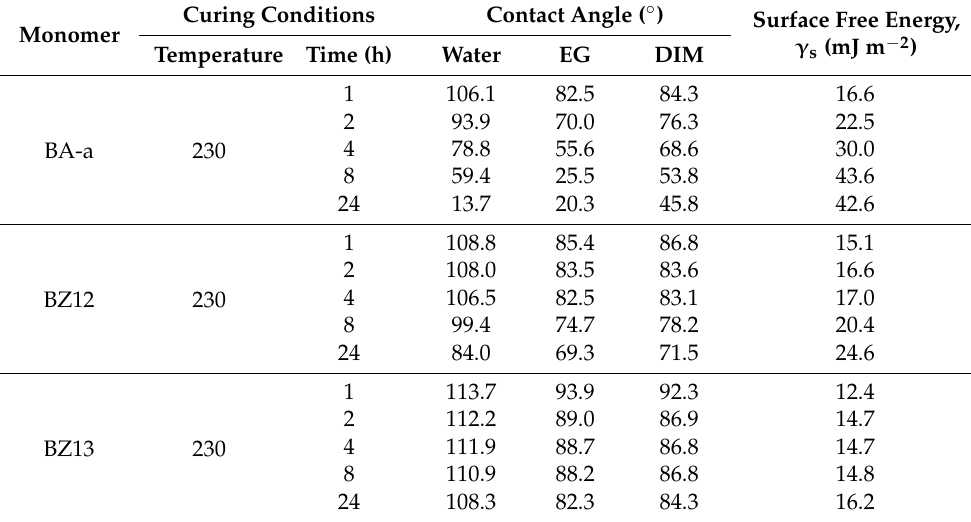
Table 3. The surface properties of polybenzoxazines derived from BA-a, BZ12, and BZ13 [43].